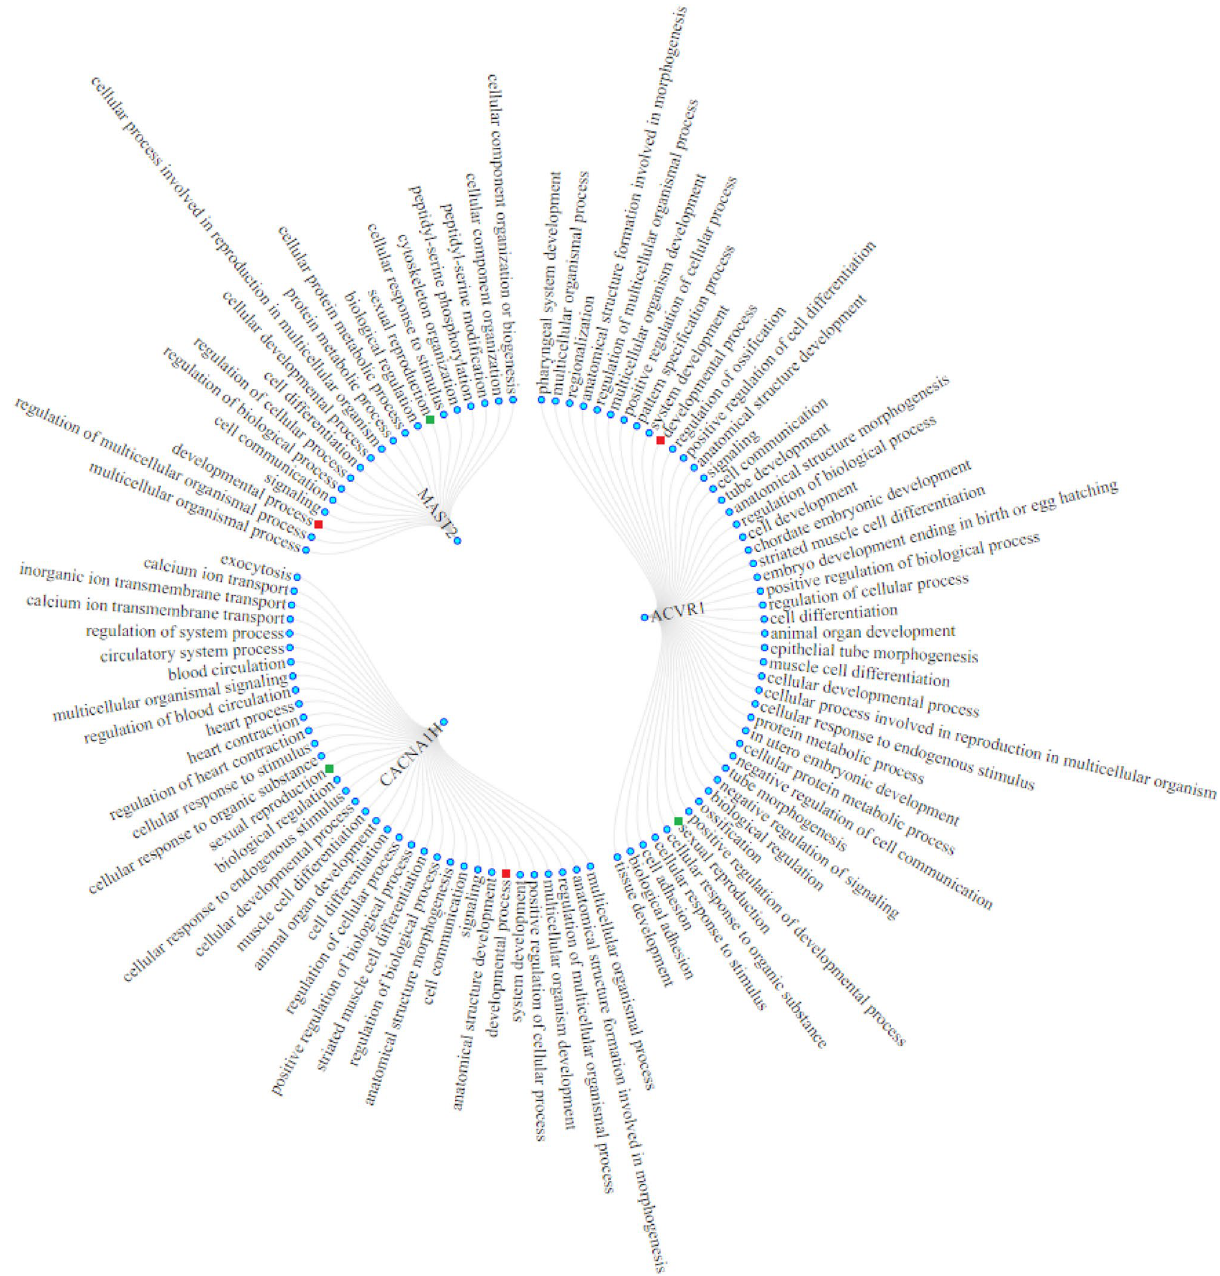
Figure 5. Radial network displaying the ACVR1, MAST2 and CACNA1H genes and their respective biological processes. Red color denotes the developmental process while reproduction is marked with green color. Figure was constructed using data.tree and networkD3 R